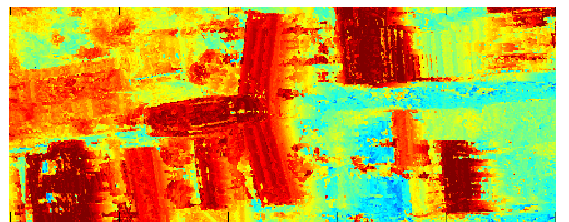
Figure 9. our method with the variational optimization.